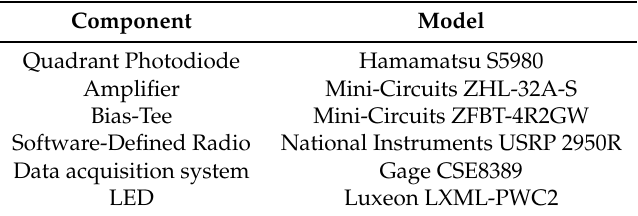
Table 2. Experimental Components.